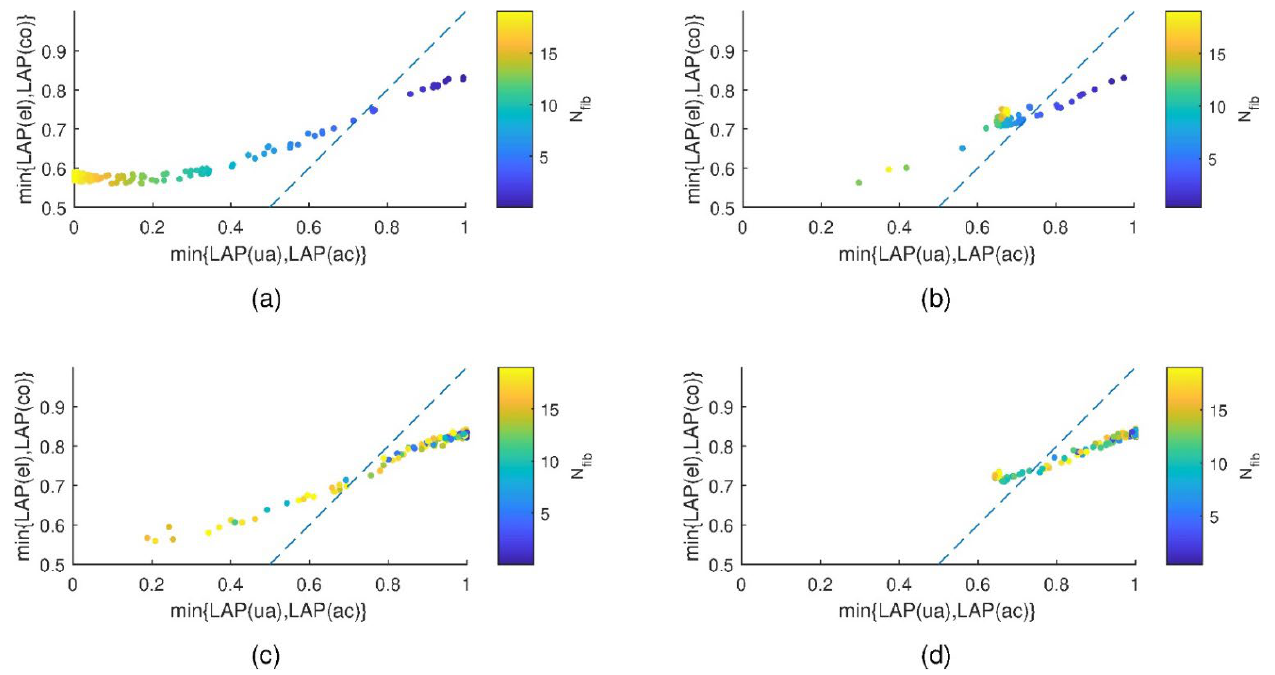
Figure 13. Minimum LAP achieved with (y-axes) and without (x-axes) implantation. The dashed lines are the lines of equality. The number of functional synapses per IHC is color-coded. The shown types of hearing losses are as follows: ( a ) CS only, ( b ) CGL + CS, ( c ) IHCL + CS, and ( d ) CGL + IHCL + CS.